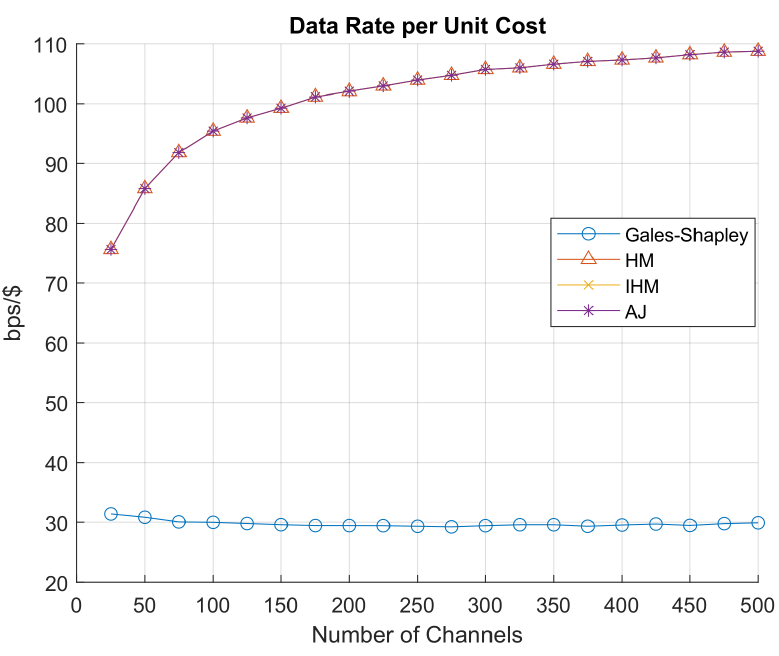
Figure 9. Datarate per unit cost.